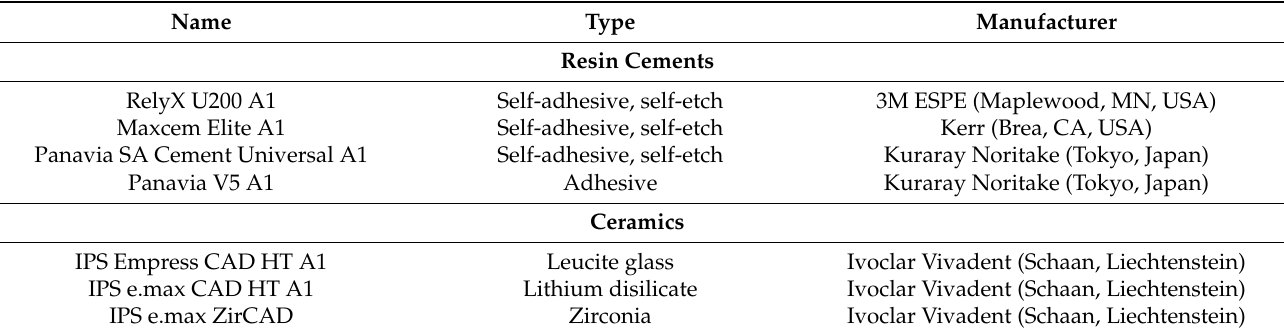
Table 4. Ceramics and resin cement manufacturers.